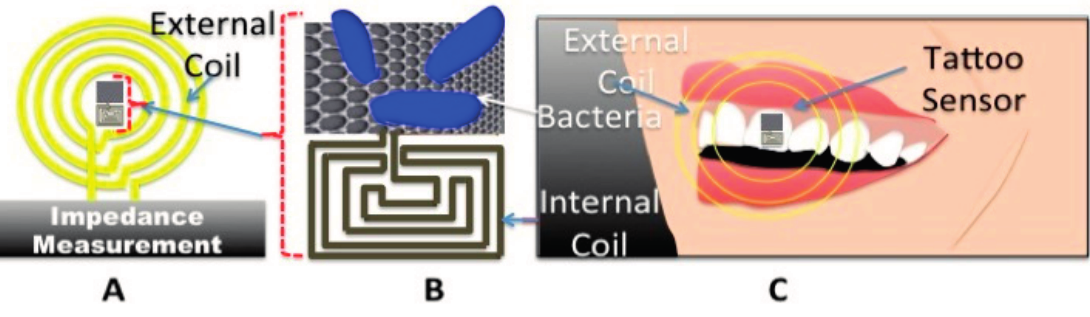
Figure 6. Remote Bio-sensing technique: Simplified diagram of ( A ) sensing technique measuring the impedance change due to the presence of bacteria; ( B ) sensing electrodes on soft substrate; ( C ) attached electrodes on